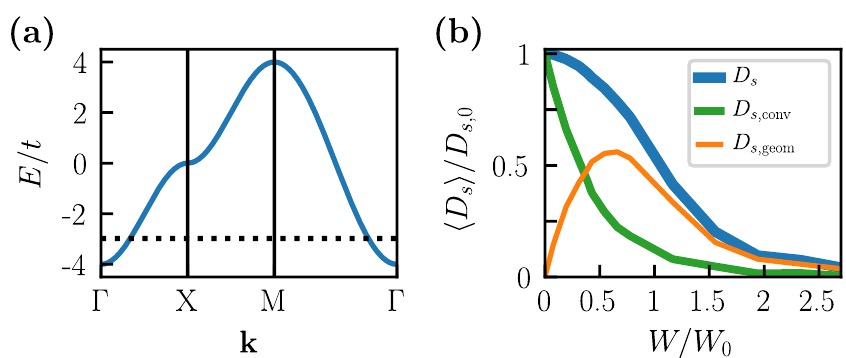
〉 in a single-band model. (a) Energy s 〉 , 〈 D 〉 and 〈 D 〉 s s ,conv s ,geom